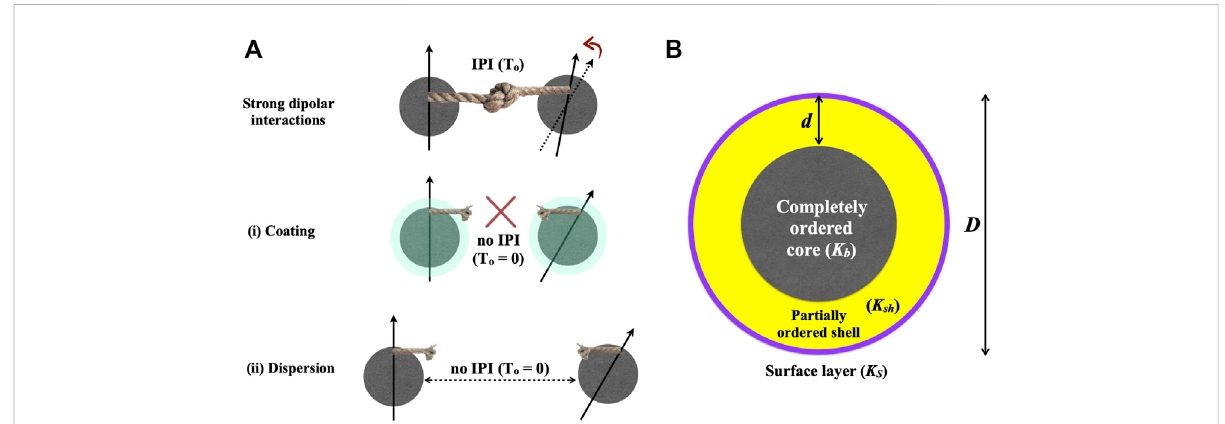
FIGURE 1 (A) Schematic representation oftheeffect ofIPI ontheeffective magnetic anistropy ( K eff )ofNPs. Theblack arrowrepresents themagnetization easy axis and rope depicts the effect of IPI on K eff . (B) Core-shell-surface layer (CSSL) geometry of a spherical magnetic NP of diameter D and shell thickness d . T 0 represents temperature corresponding to the strength of